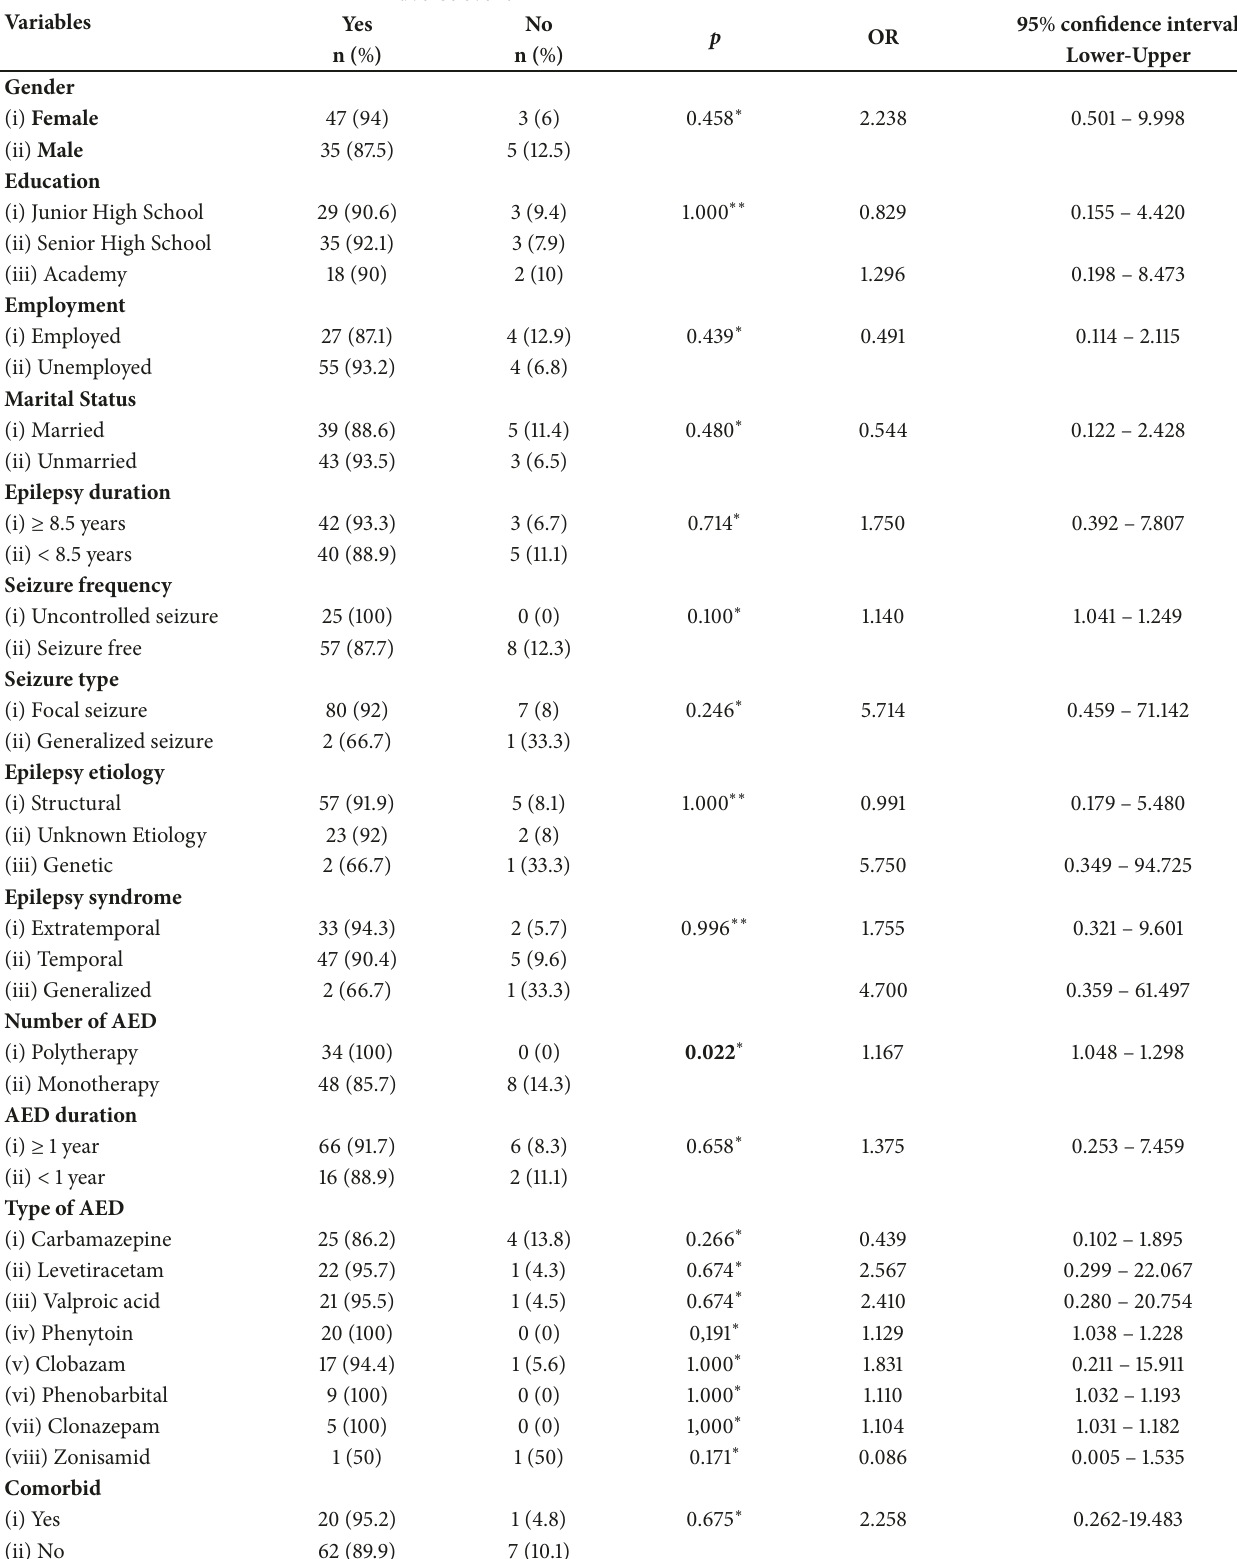
Table 3: Clinical characteristic and their relation to AEs